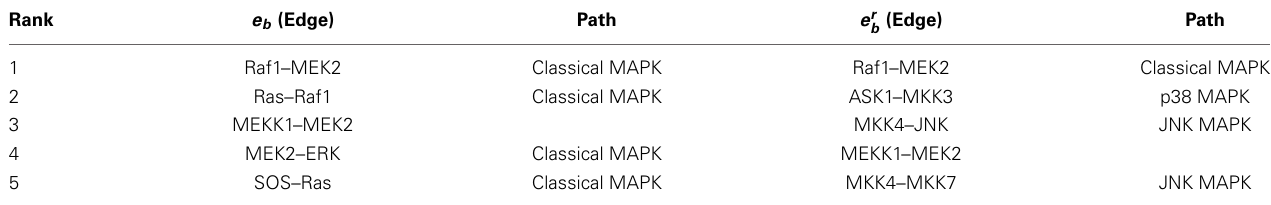
Table 6 | High betweenness edges in MAPK pathway (KEGG)